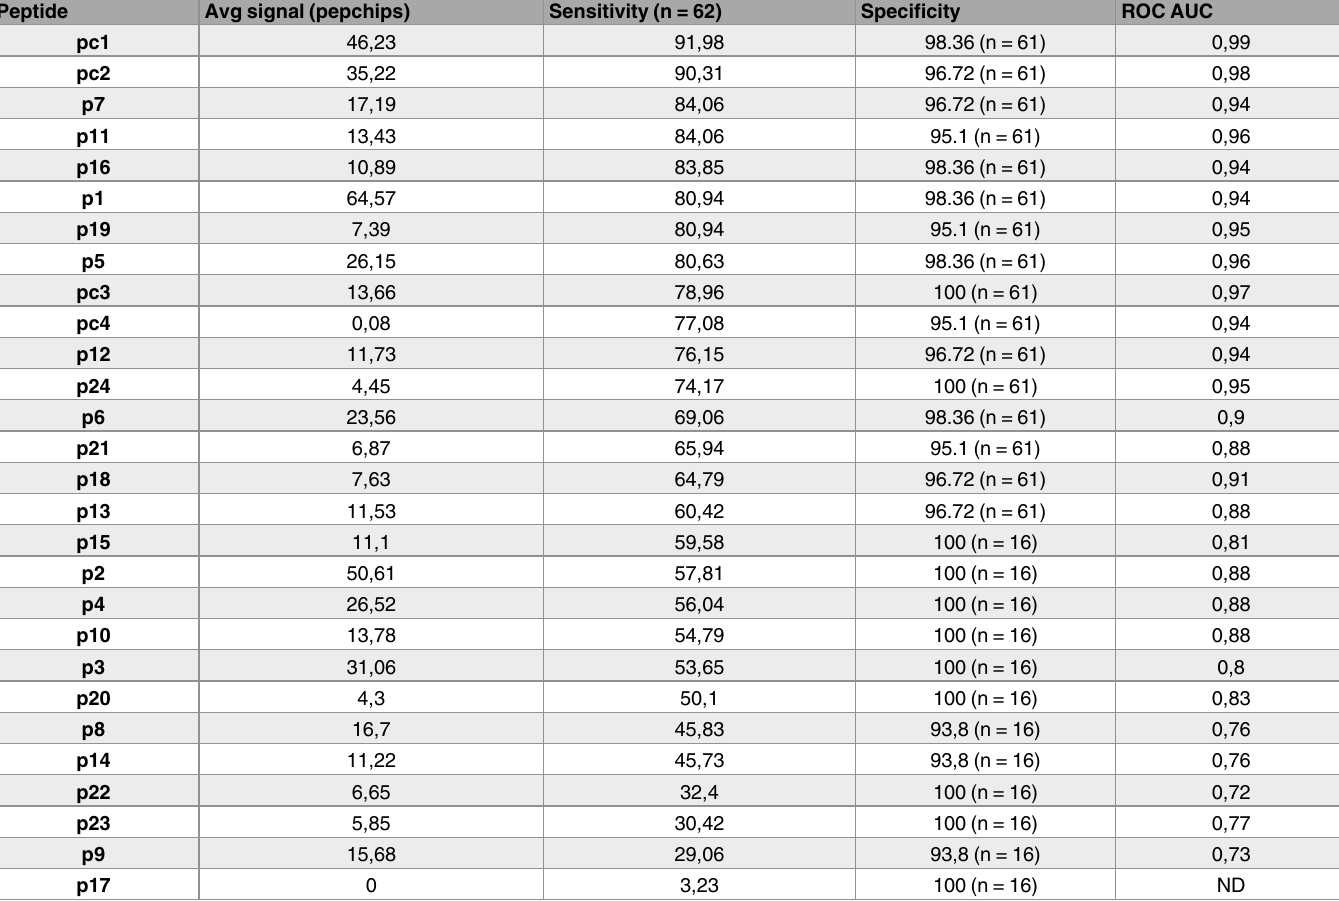
Table 2. Diagnostic performance of selectedpeptides in ELISA format. Peptides are sorted per decreasing